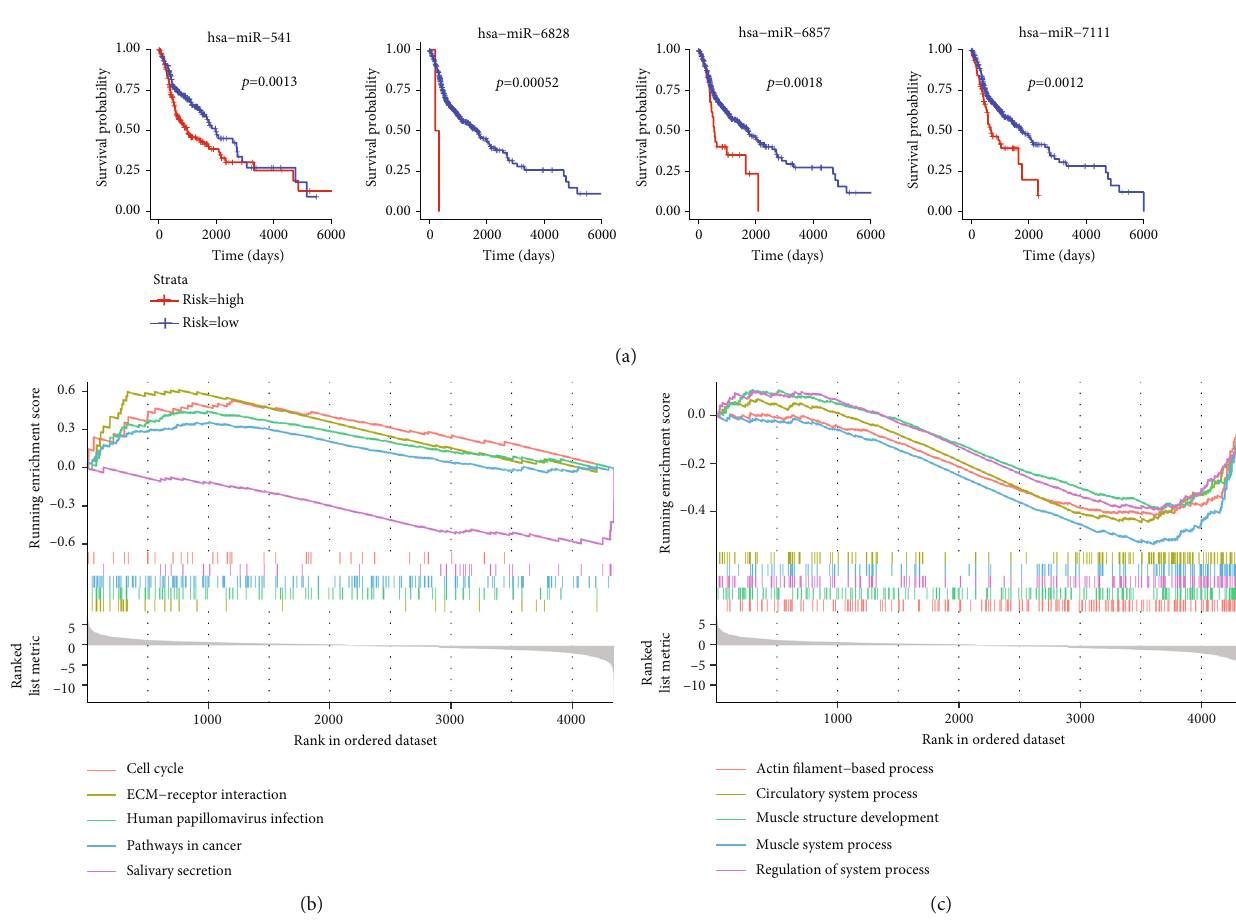
Figure 7: Kaplan – Meier plots of microRNAs related to cell components in the prognostic model and GSEA of their targeted genes. (a) Representative Kaplan – Meier plots of microRNAs related to cell components in the prognostic model, with red line representing the high-risk group and blue line representing the low-risk group. (b) KEGG pathway enrichment of 11 miRNA targeted genes in TCGA-HNSCC cohort. (c) GO enrichment of 11 miRNA targeted genes in TCGA-HNSCC